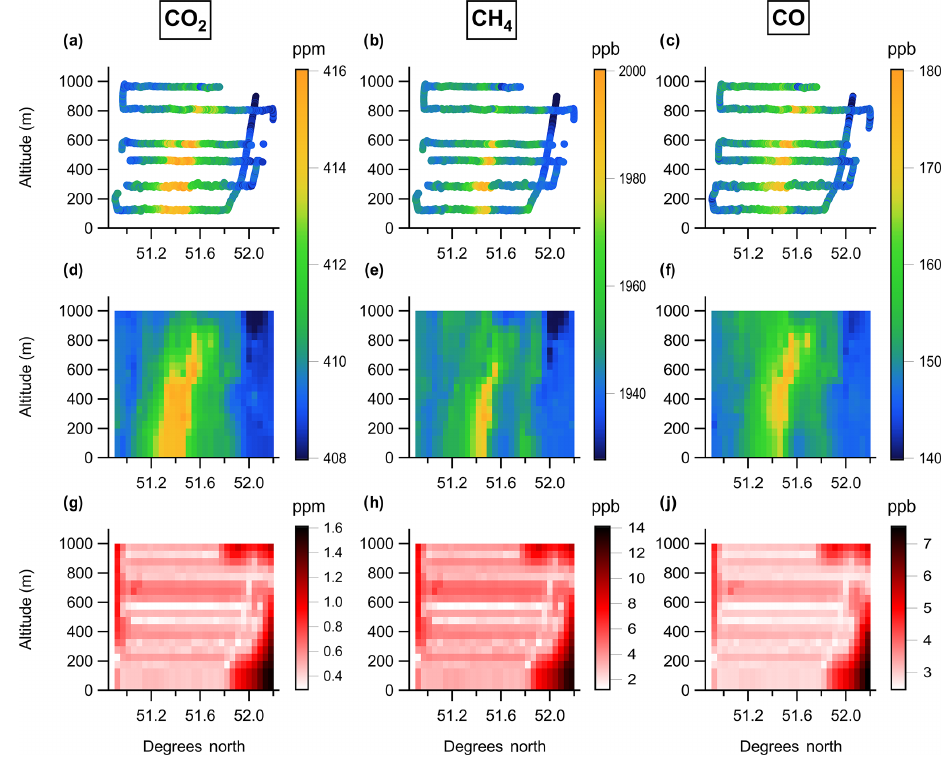
Figure 7. Altitude–latitude projections of (a–c) measured data, (d–f) kriged data, and (g–j) kriging standard error for CO 2 , CH 4 and CO respectively. Table 3. Bulk fluxes calculated using a conventional mass balance technique and corresponding NAEI emissions, aggregated over the Greater London administrative region. The ratio of mass balance flux to NAEI emission is also given. Uncertainties on spatially disaggregated emission maps are not reported in the